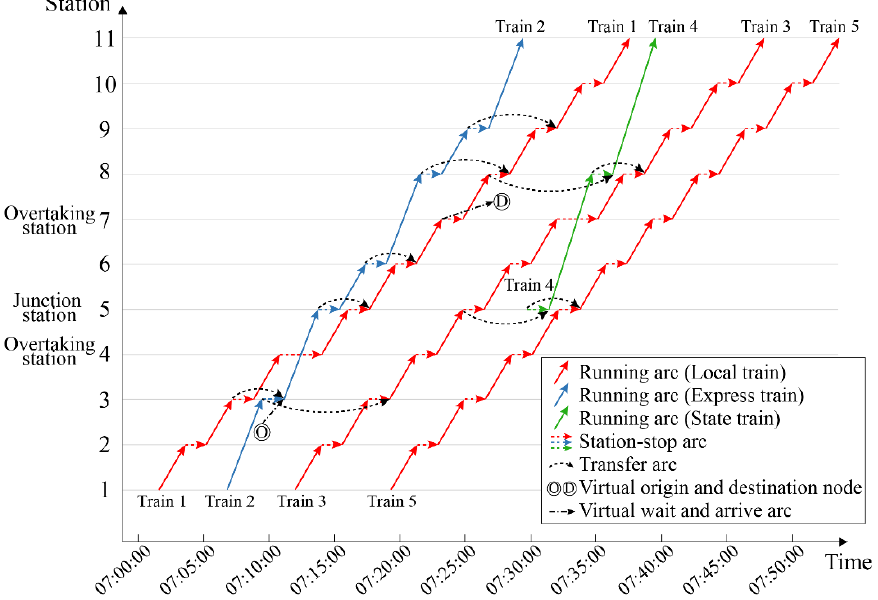
Figure 3. Schedule ‐ based network of one O–D pair under cross ‐ line and skip ‐ stop operation. Figure 3. Schedule-based network of one O–D pair under cross-line and skip-stop